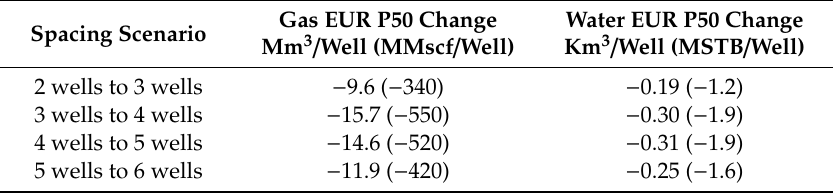
Table 4. Summary of the relative variations of gas and water for 20 years EUR P50 values for four comparison